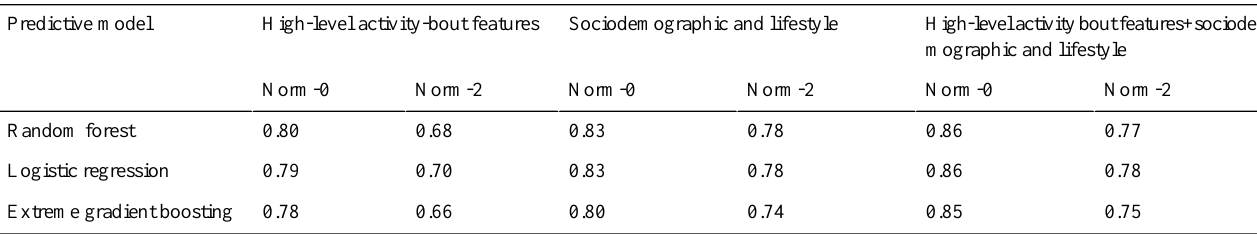
Table 3. Classification results measured using area under the receiver operating characteristic curve scores, showing the effect of choice of type 2 diabetes–negatives, Norm-0 (no physical activity impairment) versus Norm-2 (severe physical activity impairment). The values in the cells represent area under the receiver operating characteristic curve scores.